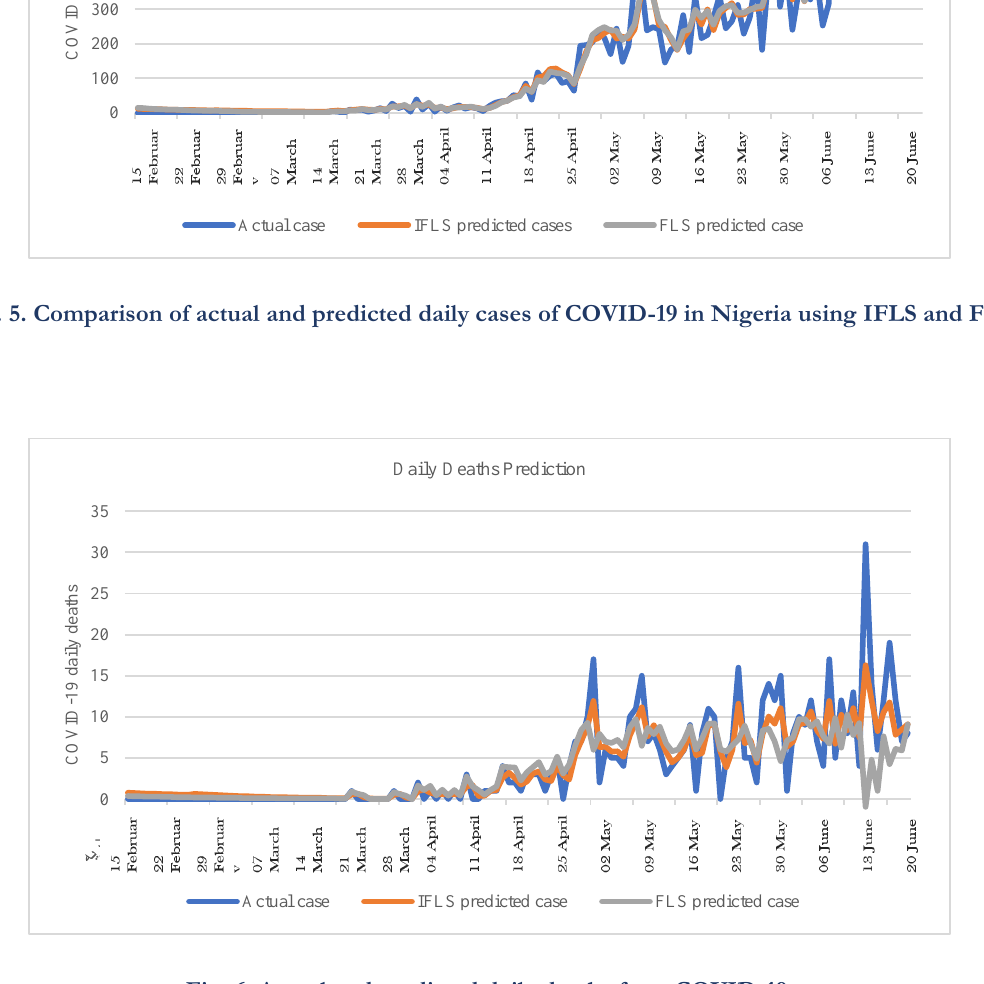
Fig. 6. Actual and predicted daily deaths from COVID-19.